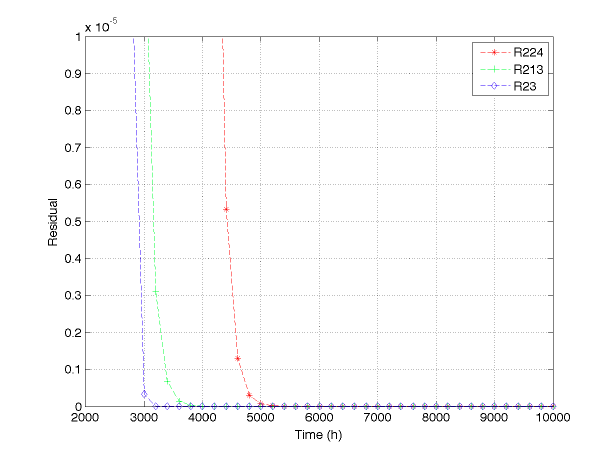
Fig. 6. Test 1: temporal evolution of residual values for models R 224, R 213 and R